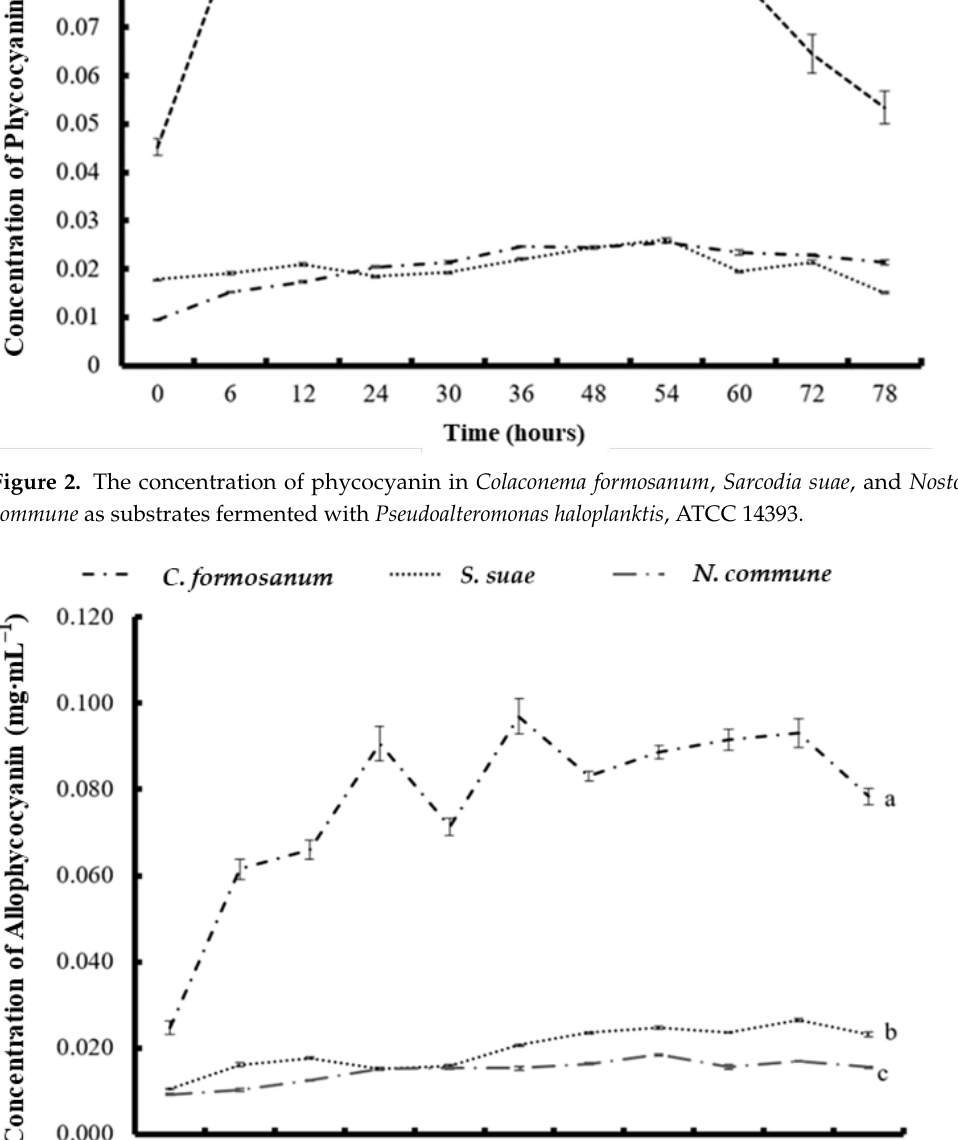
Figure 3. The concentration of allophycocyanin in (a) Colaconema formosanum , (b) Sarcodia suae , and (c) Nostoc commune as substrates fermented with Pseudoalteromonas haloplanktis , ATCC 14393.